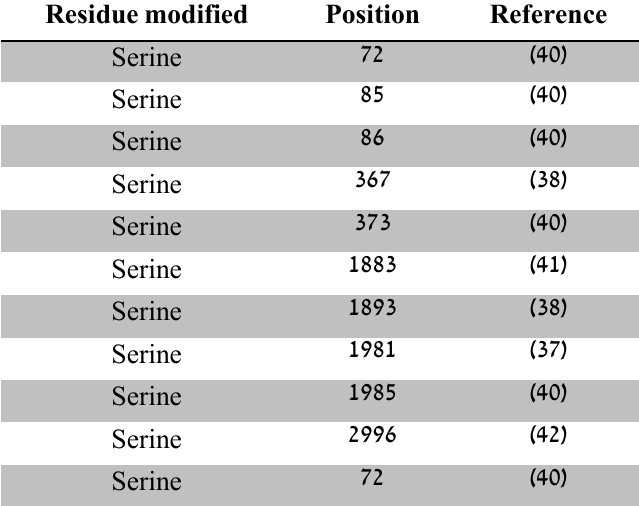
Table 1. ATM phosphorylational